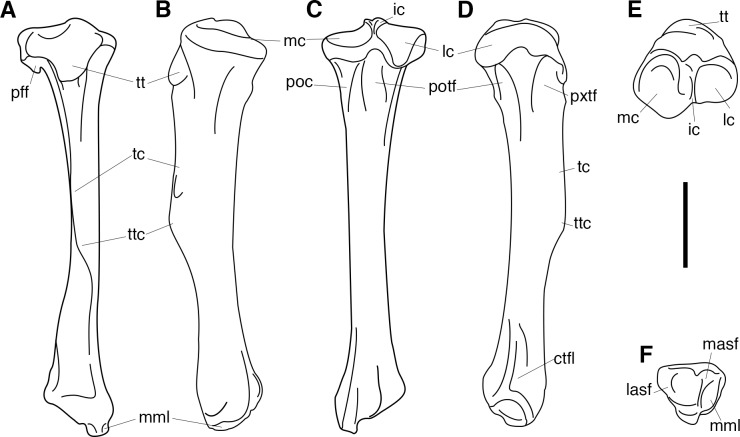
Annotated line drawing of the right tibia of Periptychus carinidens.(A) anterior view; (B) medial view; (C) posterior view; (D) lateral view; (E) proximal view; (F) distal view. Abbreviations: ctfl, crest for the tibiofibular ligament; ic, intercondyloid eminence; lasf, lateral astragalar facet; lc, lateral condyle, masf, medial astragalar facet; mc, medial condyle; mml, medial malleolus; pff, proximal fibular facet; poc, popliteus crest; potf; posterior tibial fossa; pxtf, proximal tibial fossa; tc, tibial crest; tt, tibial tuberosity; ttc, tuberosity of the tibial crest. Scale bar: 30mm.